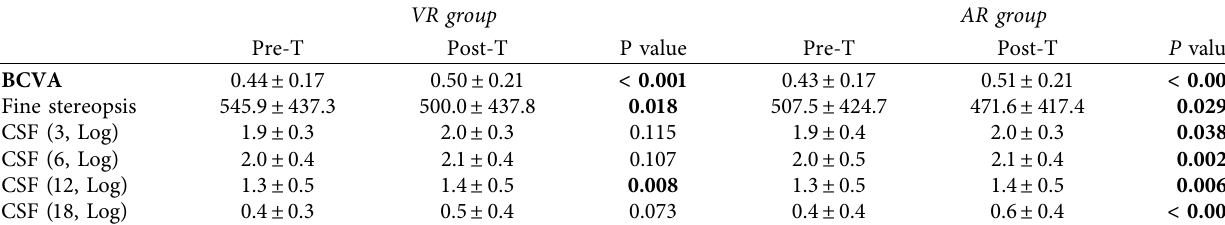
Table 2: Comparison visual function between pre- and